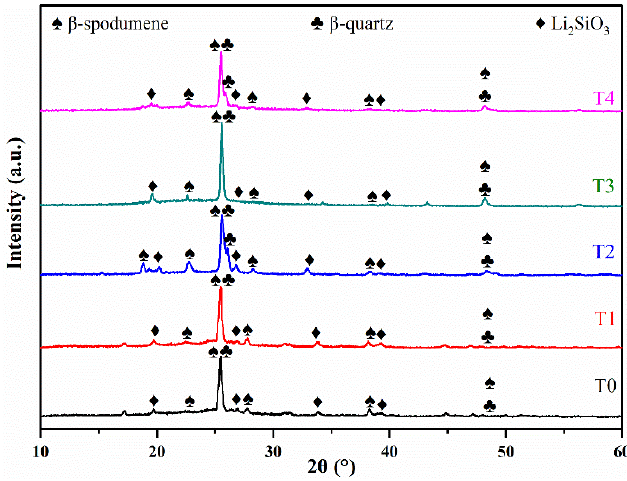
Figure 2. XRD patterns of T0-T4 LAS GCs.